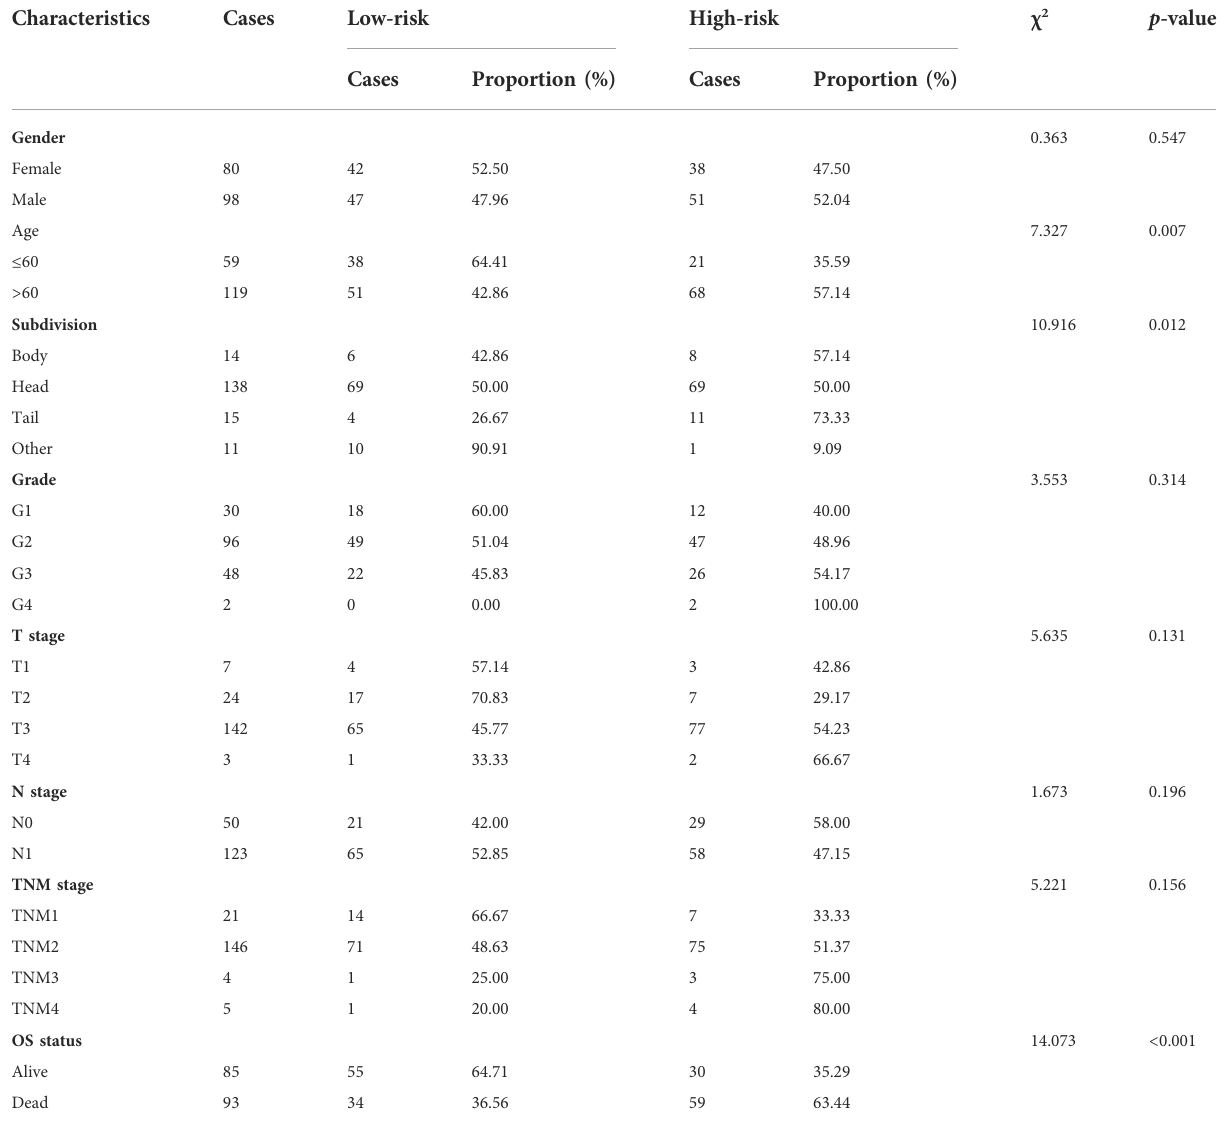
TABLE 3 Association between risk-score and patients ’ characteristics in PaCa.